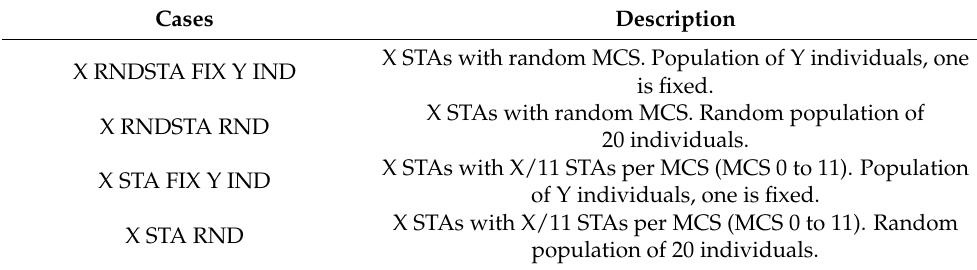
Table 1. Alternatives for initial